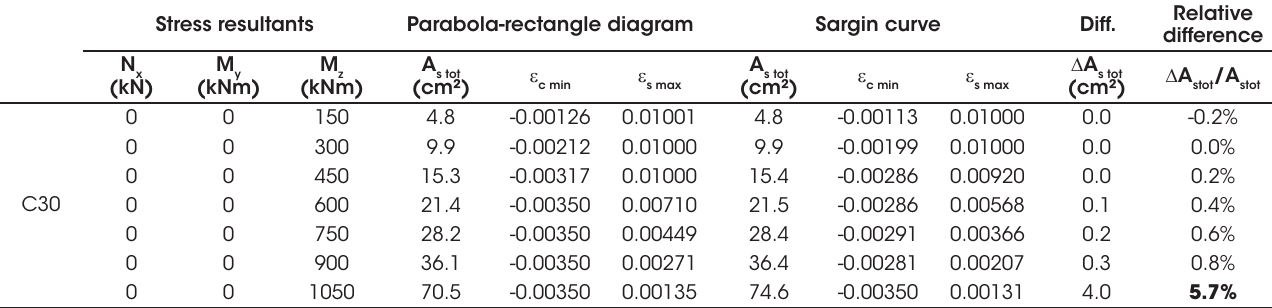
Singly-reinforced cross-section subjected to pure bending Stress resultants Parabola-rectangle diagram Sargin curve Diff.